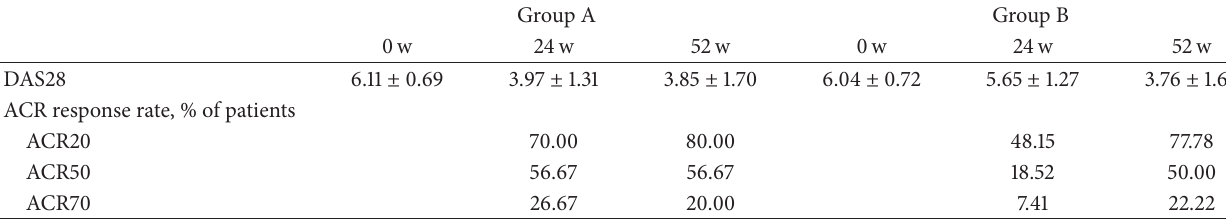
Table 1: Clinical assessment of RA patients undergoing iguratimod